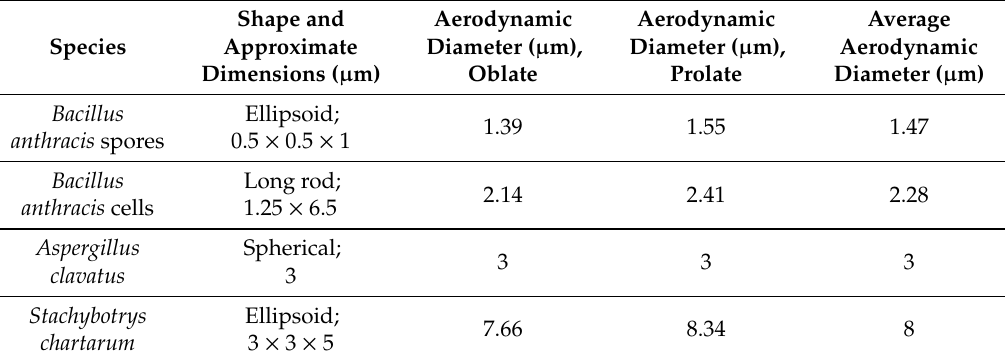
Table 2. Size of microorganism species used in model runs